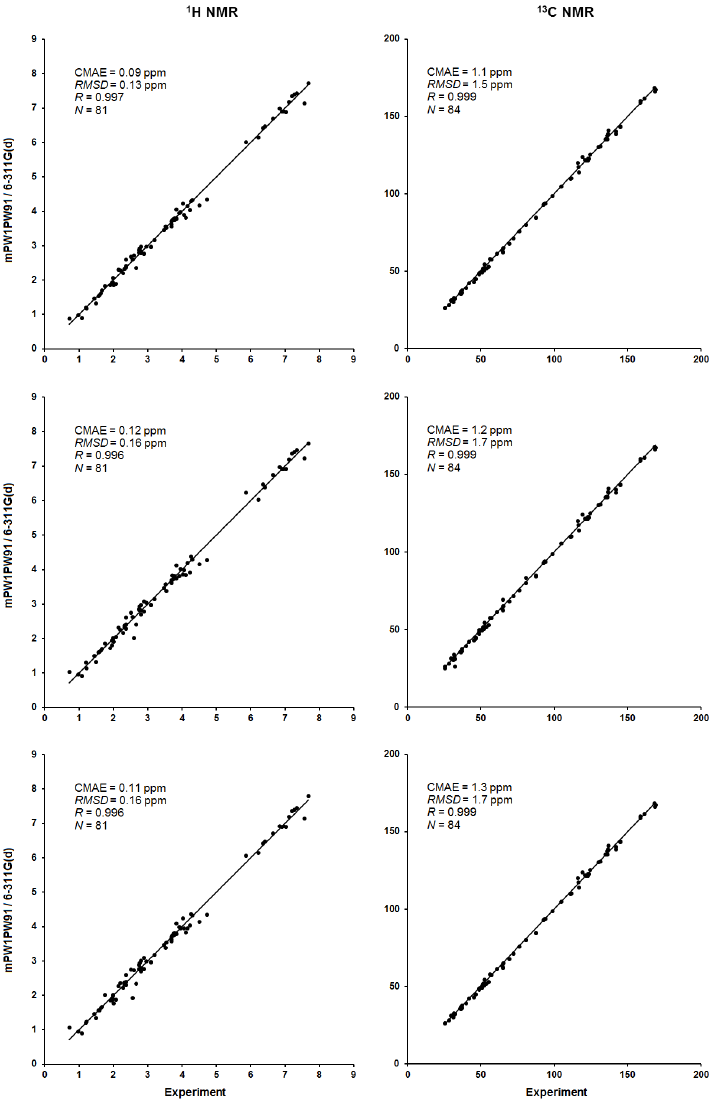
Figure 13. Correlation plots of calculated vs. experimental 1 H and 13 C NMR chemical shifts, ppm (left and right, respectively) for the key configurations 0 (top), 15 ′ (middle), and 15 ‴ (bottom) of alasmontamine A.